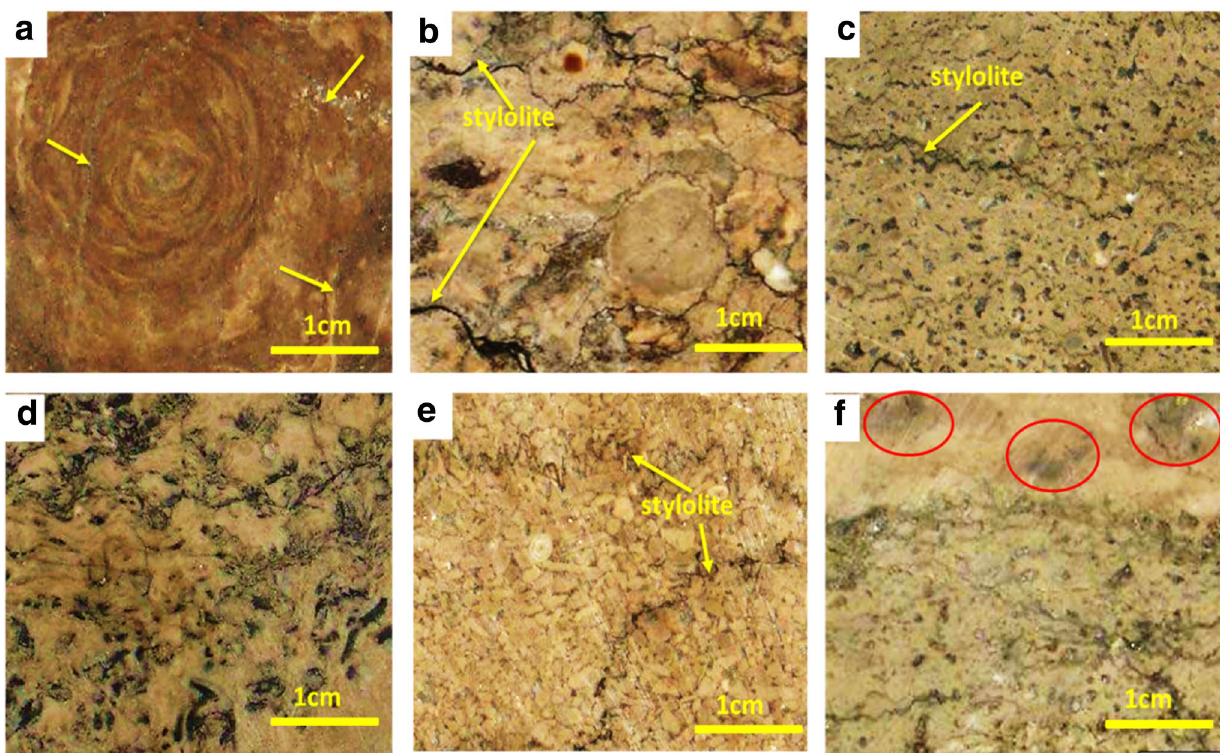
Fig. 5 Core photographs of the reef and shoal facies showing: a argillaceous algae oncoid packstone, with nodules of algae oncoids consisting of alternating light algal calcarenite and reddish brown, tight argillaceous–micritic layers. Fracture filled with sparry calcite (yellow arrows) (MF-1); b intraclasts, bioclastic nodular packstone (MF-9, MF-15), large fragments of corals, bryozoan, with the nod- ules separated by low- to medium-amplitude stylolites; c intraclasts, bioclastic packstone (MF-9), composed of sand–gravel-sized angular bioclastic disbris and lithoclasts; d ostracods, coral, oyster wacke-